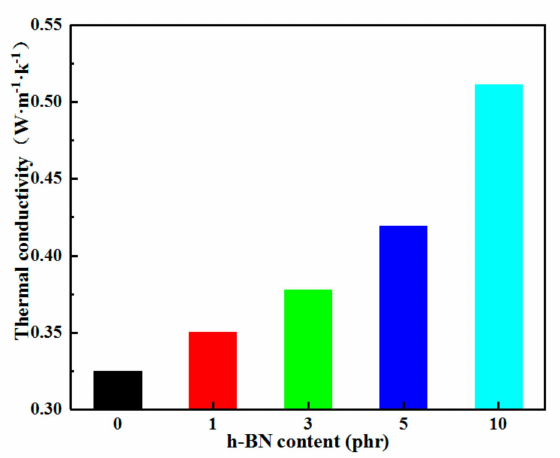
Figure 4. Thermal conductivity of LDPE and the